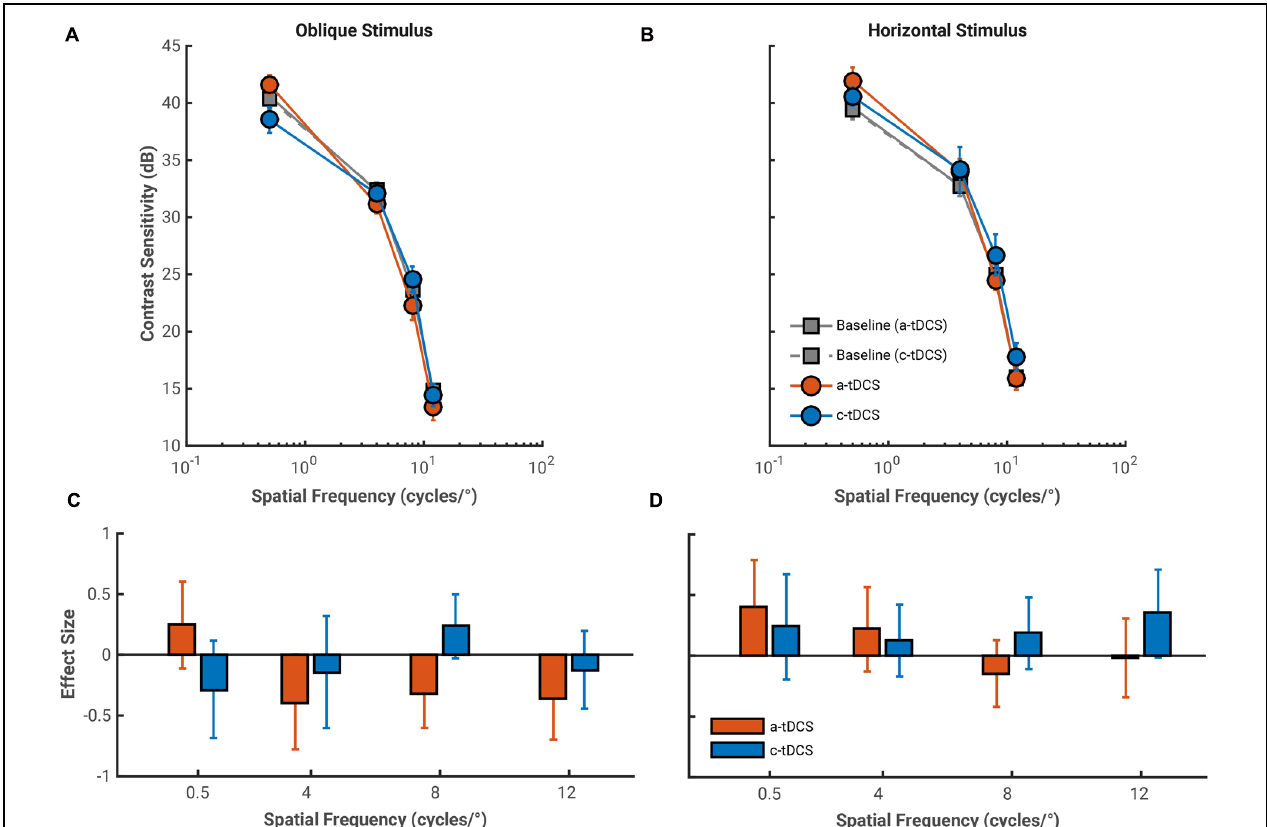
FIGURE 3 | Average pre-stimulation (gray) and stimulation contrast sensitivity functions (CSFs) for both a-tDCS (red) and c-tDCS (blue) measured with the oblique (A) and horizontal (B) fixed period gratings (at spatial frequencies of 0.5, 4, 8, and 12 cycles/ ◦ ). Contrast sensitivity is presented in decibels (dB). Error bars represent the standard error of the mean difference calculated across observers. (C,D) The effect sizes of the mean difference contrast sensitivity measured at stimulation and at pre-stimulation for oblique and horizontal conditions, respectively. For oblique gratings, contrast sensitivity measured at 8 cycles/ ◦ showed a polarity specific effect of tDCS, whereby a-tDCS decreased and c-tDCS increased contrast sensitivity. Error bars represent the exact 95% confidence interval of the effect size. We used error bar overlap to assess the magnitude of tDCS effects on contrast sensitivity. Thus, error bars that do not contain 0 and do not overlap with changes in contrast sensitivity with the other tDCS polarity are considered “significant”.